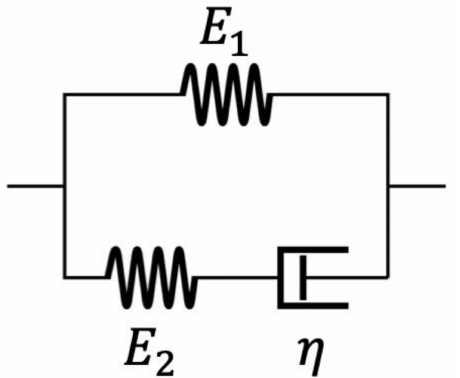
Figure 1. The Maxwell form of the standard linear solid model. E 1 , E 2 and η are three parameters in the model relevant to the viscoelastic